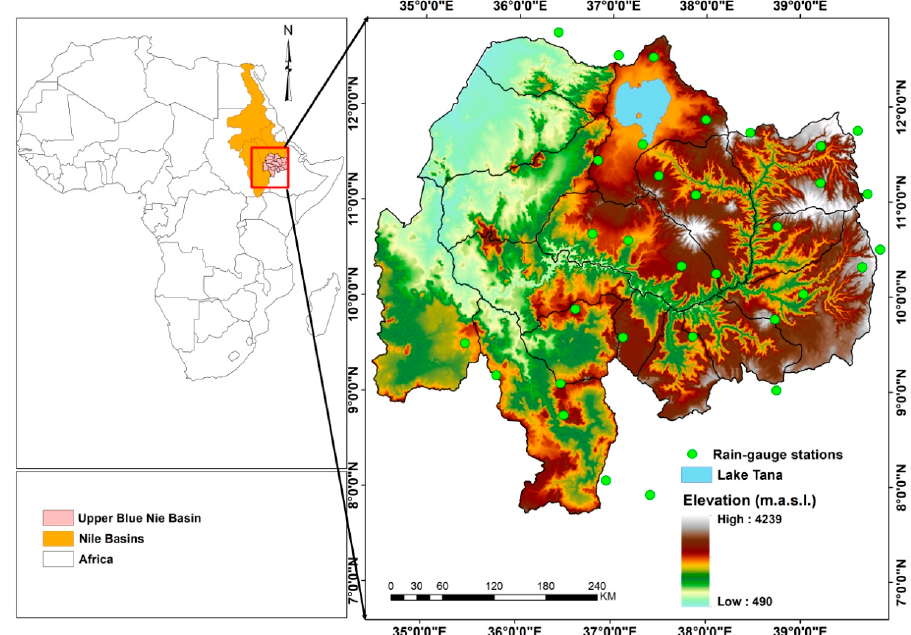
Figure 1. Location of the Upper Blue Nile Basin (UBNB) (Imagery source for UBNB: Shuttle Radar Topography Mission (SRTM) Global elevation data). The green bold point shows the distributions of rain gauge stations used to validate the performance of the Climate Hazards Group InfraRed Precipitation with Station (CHIRPS) satellite rainfall